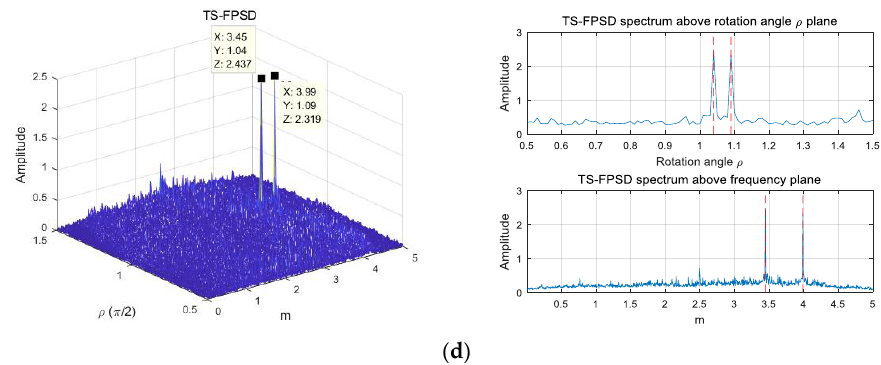
Figure 8. The spectrum of FPSD, FLOS-FPSD, and TS-FPSD under the S α S noise with GSNR = 5dB and α = 1.3. ( a ) The FPSD spectrum of the echo and its rotation angle plane and the frequency plane; ( b ) The FLOS-FPSD with a p = 1.4 spectrum of the echo, and its rotation angle plane and the frequency plane; ( c ) The FLOS-FPSD with p = 1.0 spectrum of the echo, and its rotation angle plane and the frequency plane; ( d ) The TS-FPSD spectrum of the echo, and its rotation angle plane and the frequency plane.